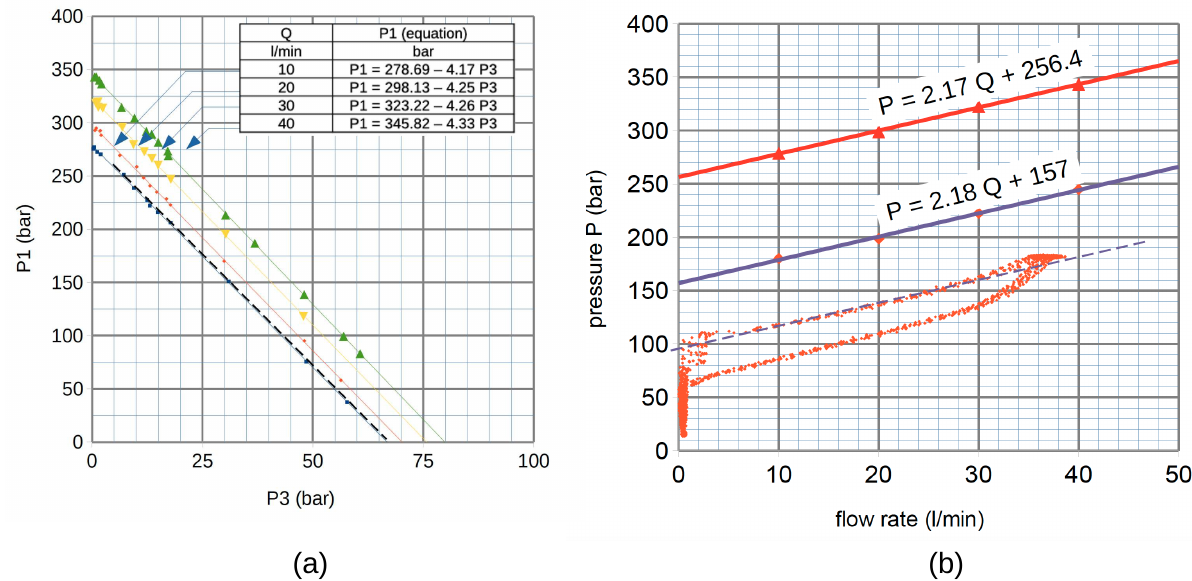
Figure 10. LHV experimental curves: ( a ) steady-state operating curves and ( b ) relief function curve.